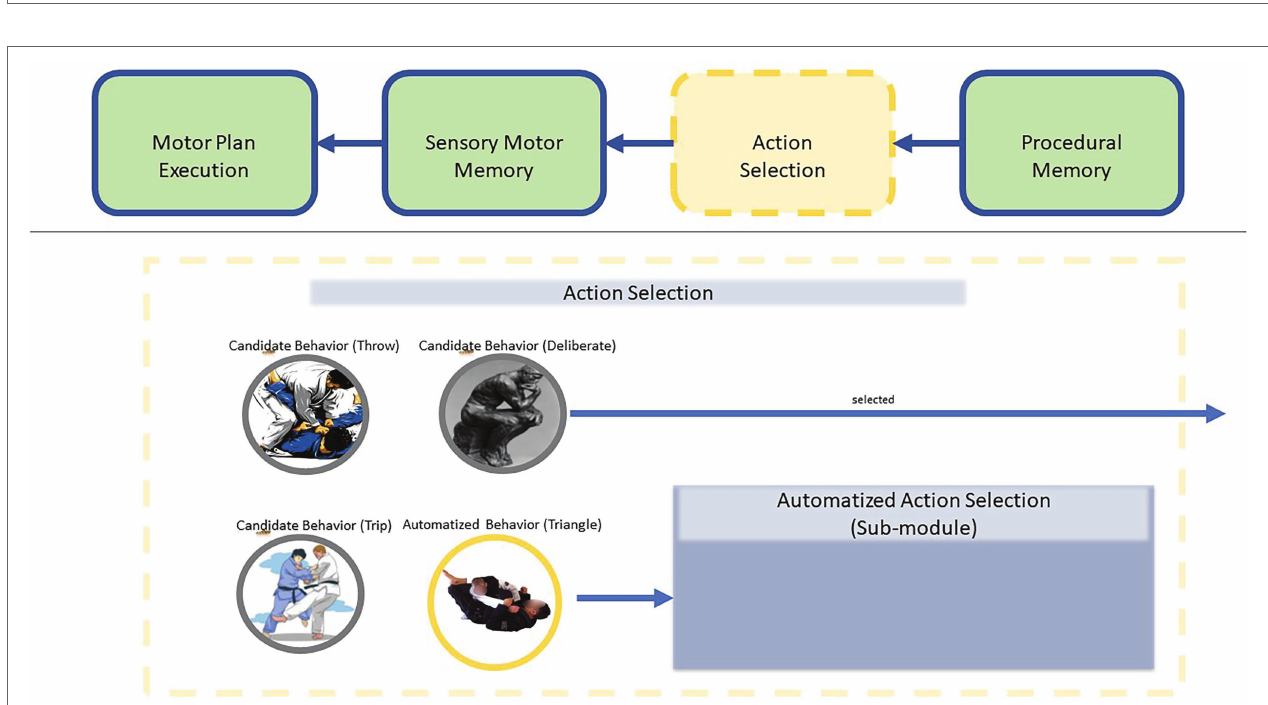
FIGURE 5 | Above are three of the virtuous cycles in LIDA agent smooth coping. The first cycle demonstrates the affordance action cycle step by step. The second cycle demonstrates the relationship between expectation codelets new affordances and action. As an agent acts, they also generate expectation codelets and such codelets increases the chance of action-related affordances winning the competition for consciousness. Such biasing of attention in turn creates more actions. Finally, the skill cycle demonstrates how affordances lead to the creation of appropriate behavior schemes and executing behaviors in turn leads to the perception of new affordances.